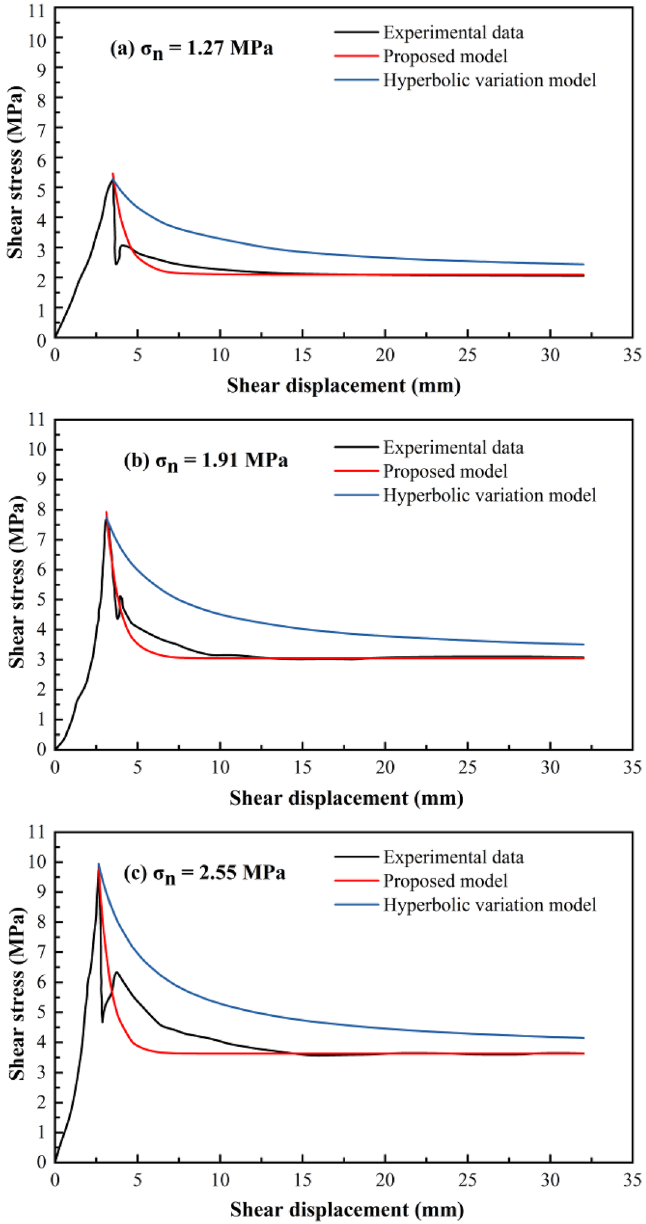
Figure 16. Comparison between the calculated post-peak shear stress values as a function of the shear